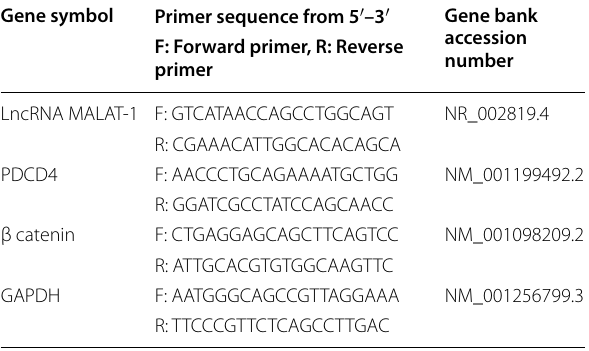
Table 1 Primers sequence of studied genes Gene symbol Primer sequence from 5 ′ –3 ′ Gene bank